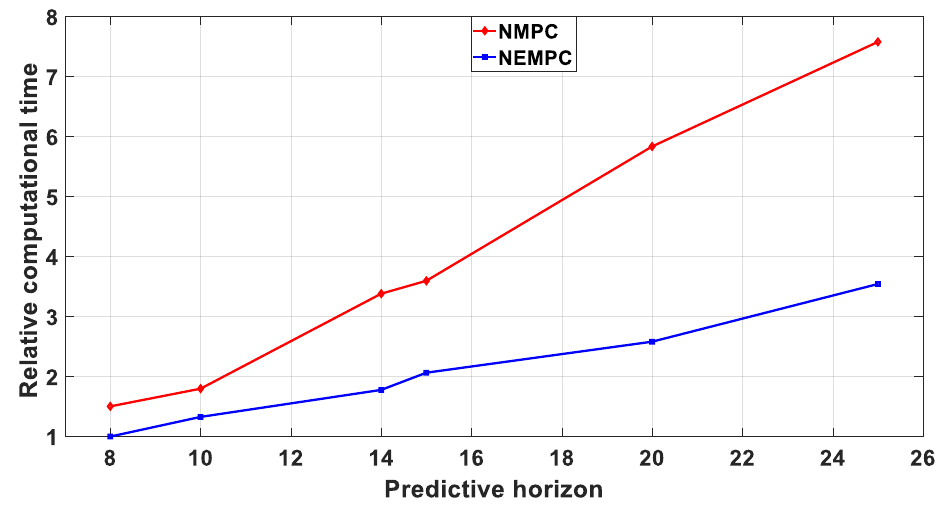
Figure 12. Relative computational times for various predictive horizons.